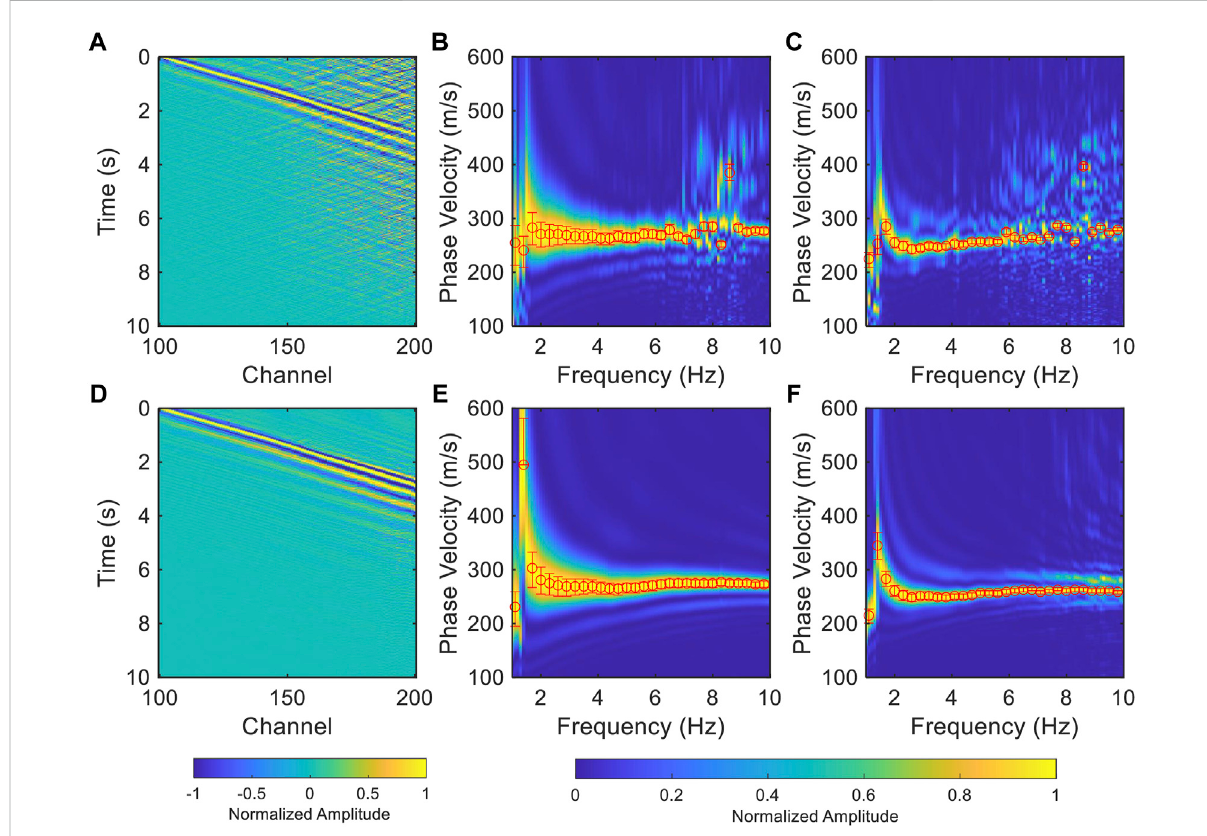
FIGURE 9 The improvement of the resolution of dispersion spectra of the long segment with the TSI method. (A) The NCFs of a long segment (black dashedboxinFigure1). (B) ThedispersionspectrumiscalculatedusingthewaveformsofCH100-150,theredbarsarethepickeduncertaintieswhich is de fi ned as the zone with 90% of the maximum energy of each frequency. (C) is same as (B) but for CH100-200. (D – F) same as (A – C) but for the denoised waveforms using the TSI